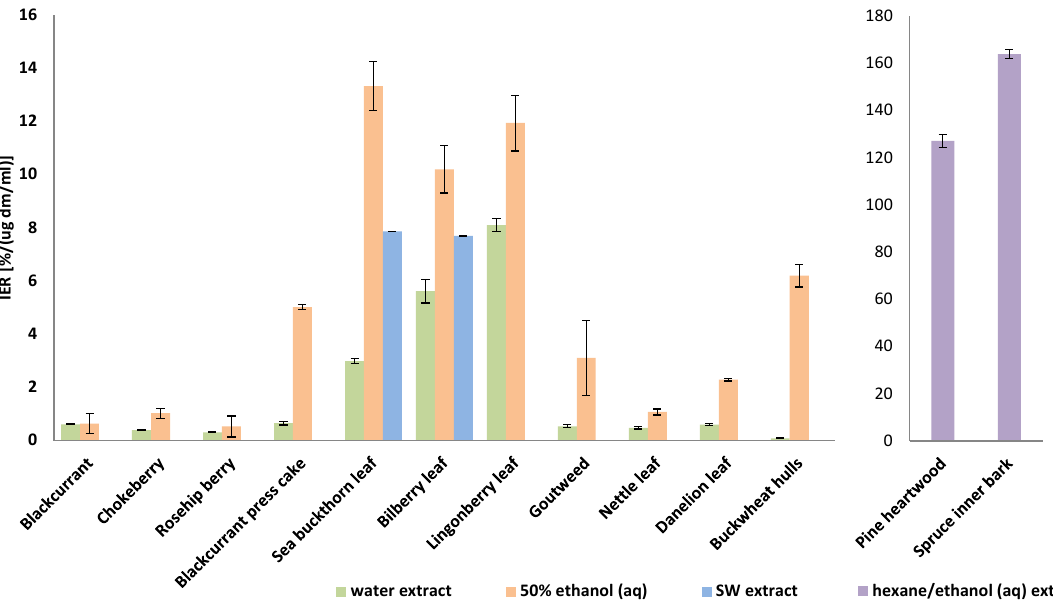
Figure 3. Capacity of the selected plant extracts to prevent lipid oxidation in a liposome model in IER values [%/(ug dm/mL)].